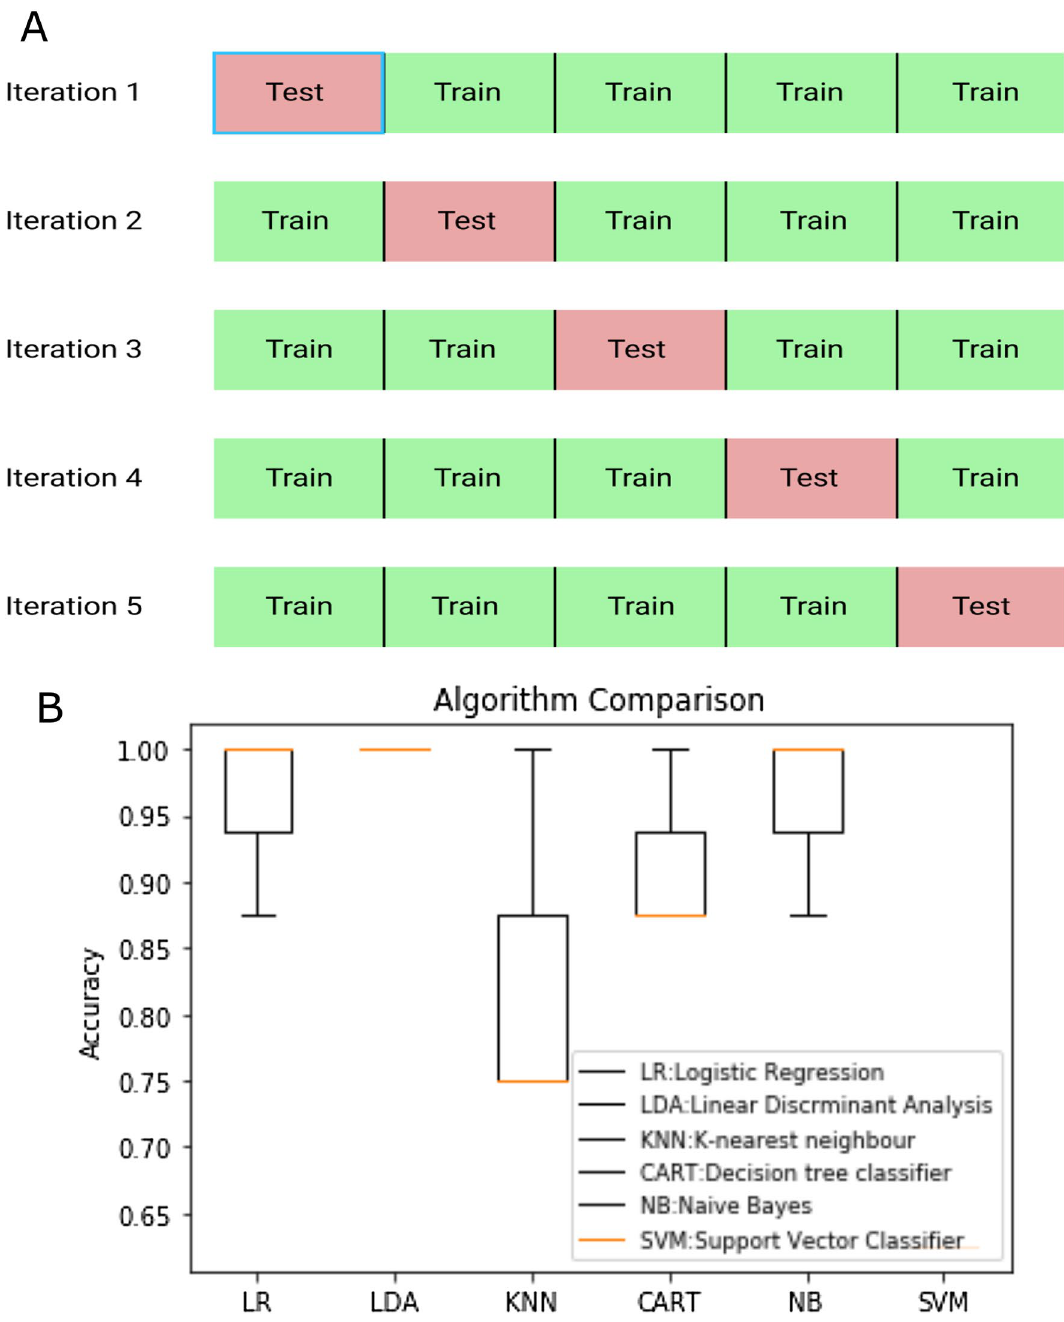
Figure 4. ( A ) k-fold validation method with illustration of k = 5, ( B ) is the comparison from k-fold validation of linear regression(LR), Linear Discriminant Analysis(LDA), k-Nearest Neighbor (KNN), Classification and Regression Tree(CART), Naïve Bayes(NB), Support Vector